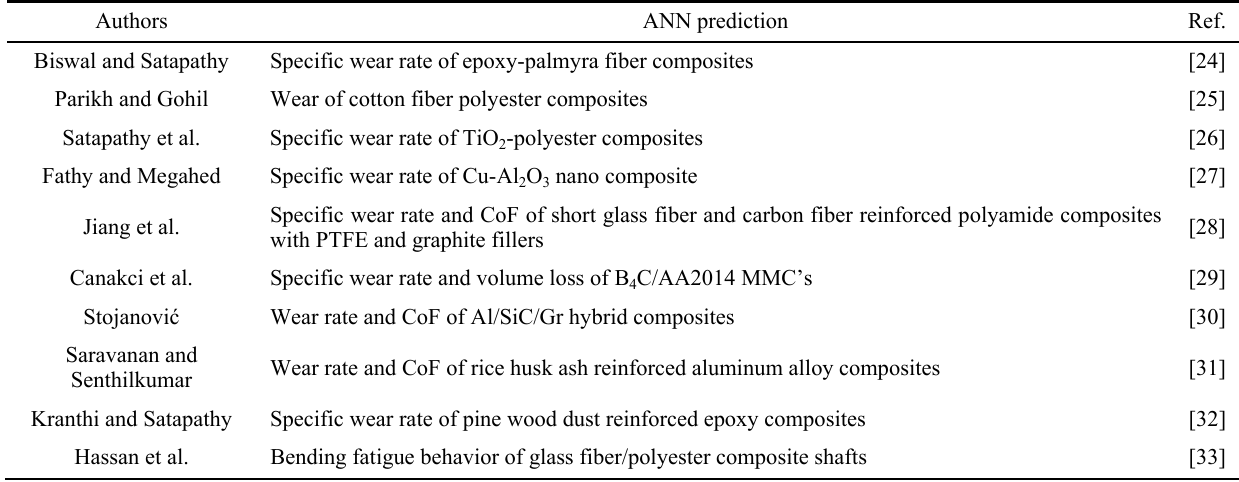
Table 4 Tribology results and fatigue behavior of composites predicted using ANN.